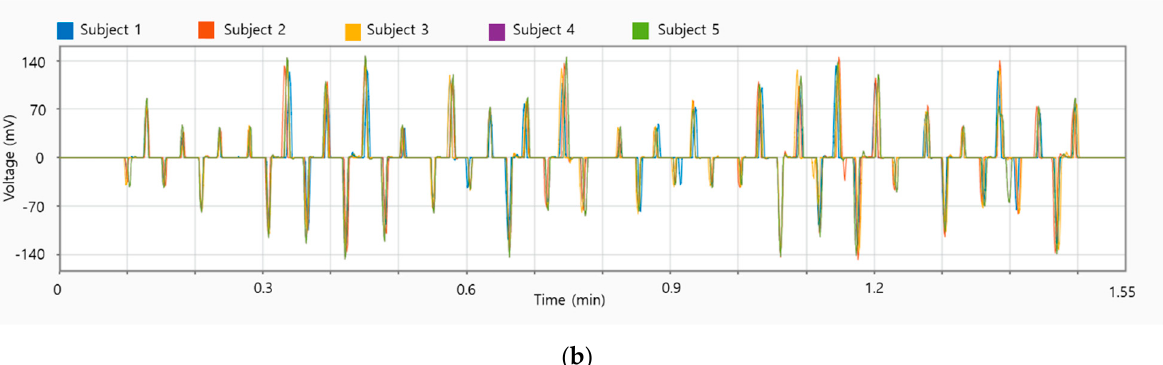
Figure 6. Deviation of EOG for feature extraction: ( a ) DEFEOG for six subjects; ( b ) MFDEOG for six subjects.